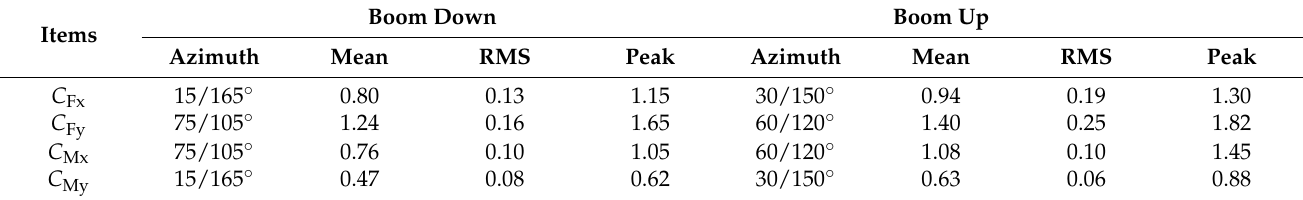
Table 2. The most unfavorable azimuths and values for each wind force/moment